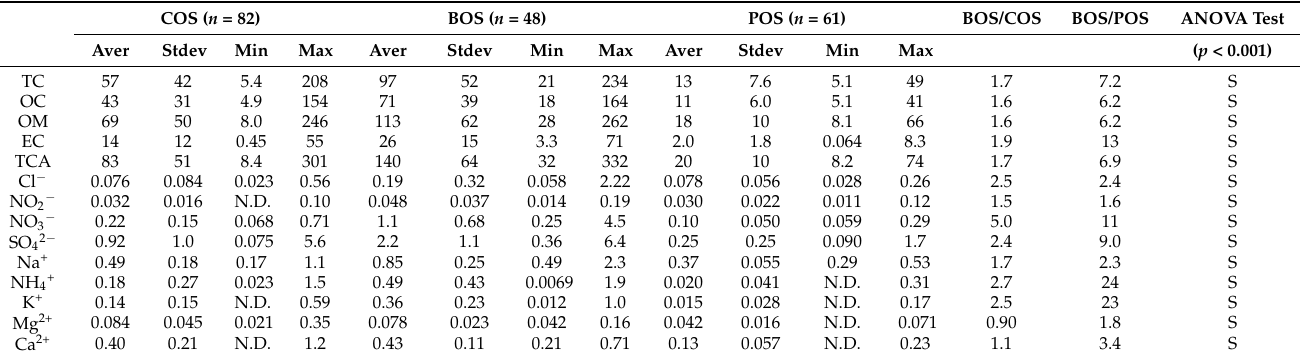
Table 1. Statistical description of the TC, OC , EC , OM. TCA, and WSIS in PM 2.5 ( µ g m − 3 ) collected during COS, BOS, and